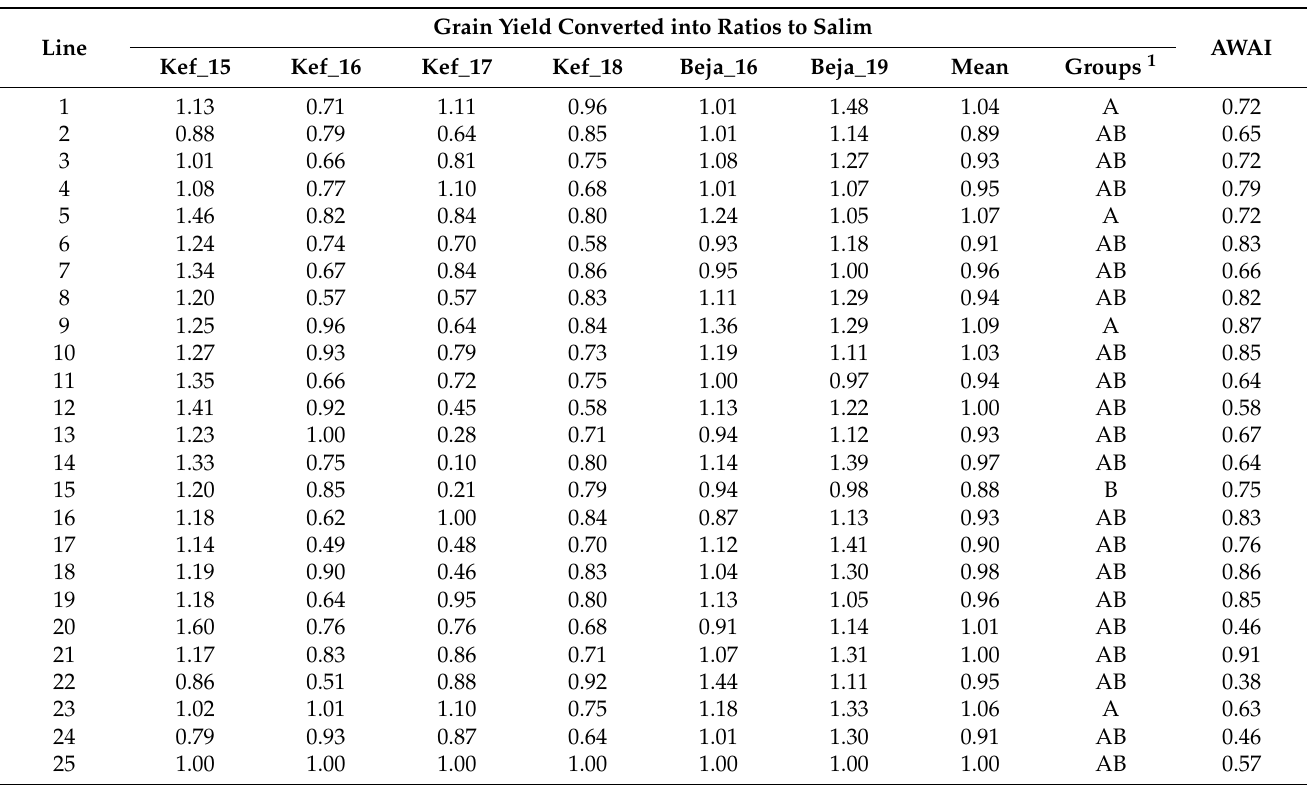
Table 5. Mean grain yield of 24 durum wheat lines converted into ratios to Salim (grain yield rate) across the six environments.